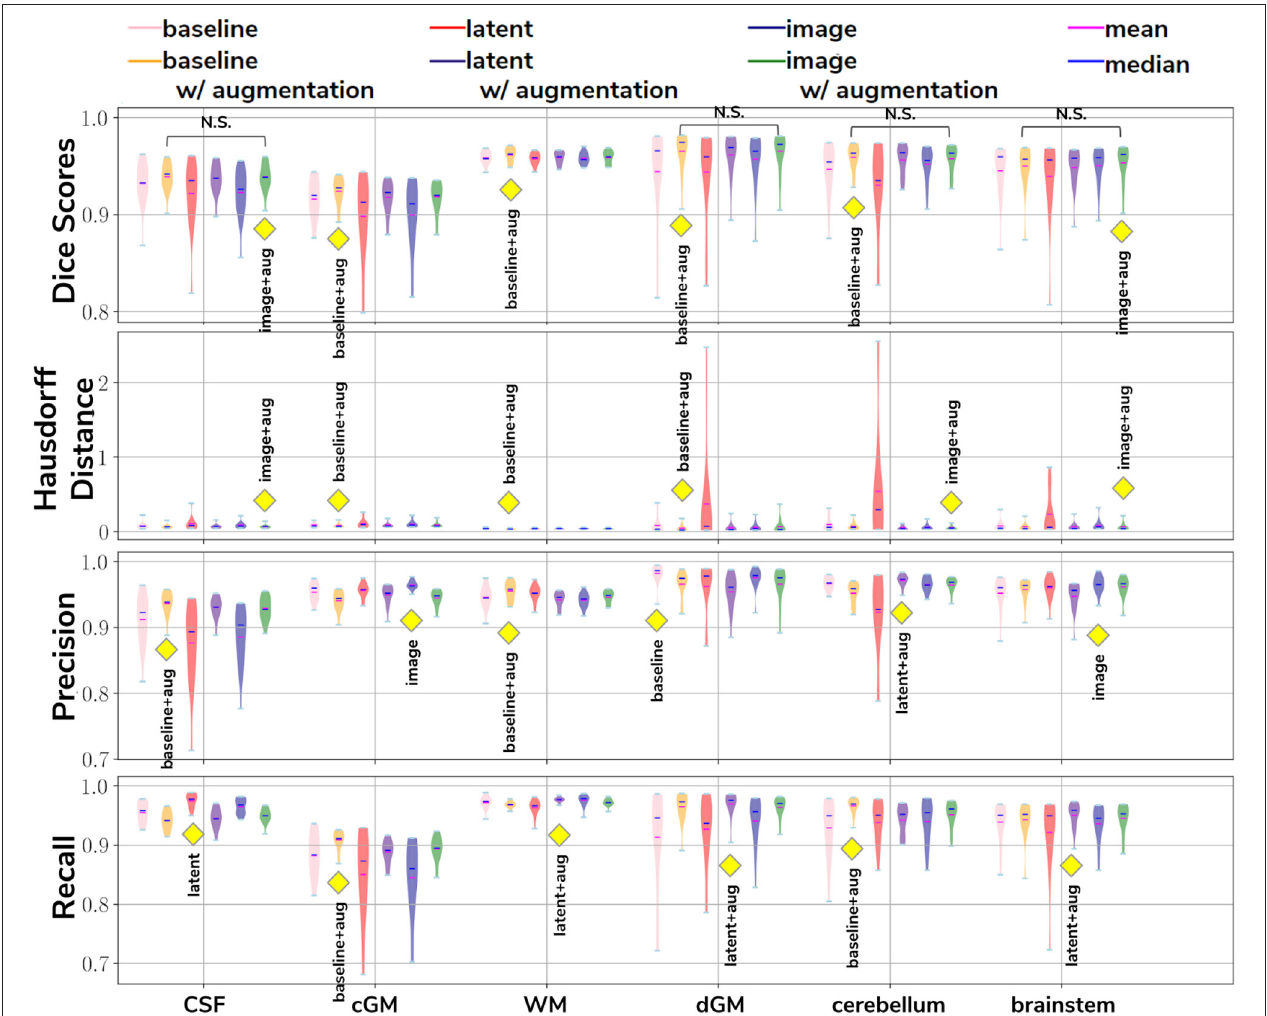
FIGURE 5 | The results on our dHCP test dataset for all six methods. The yellow diamond highlights the model which obtained the best mean score for its respective tissue type and metric. Models which obtained non-significant differences when compared to the best performing method are shown above each pair.